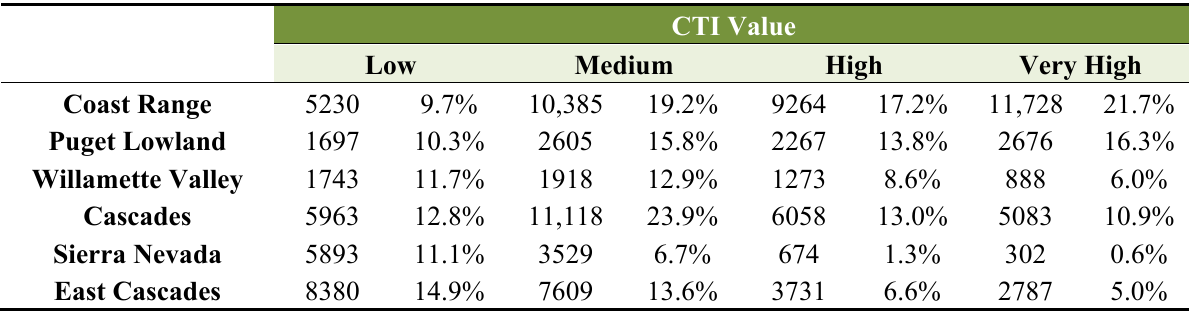
Table 7. Conversion Threat Index from 2000 to 2100 for ecoregions in the Pacific